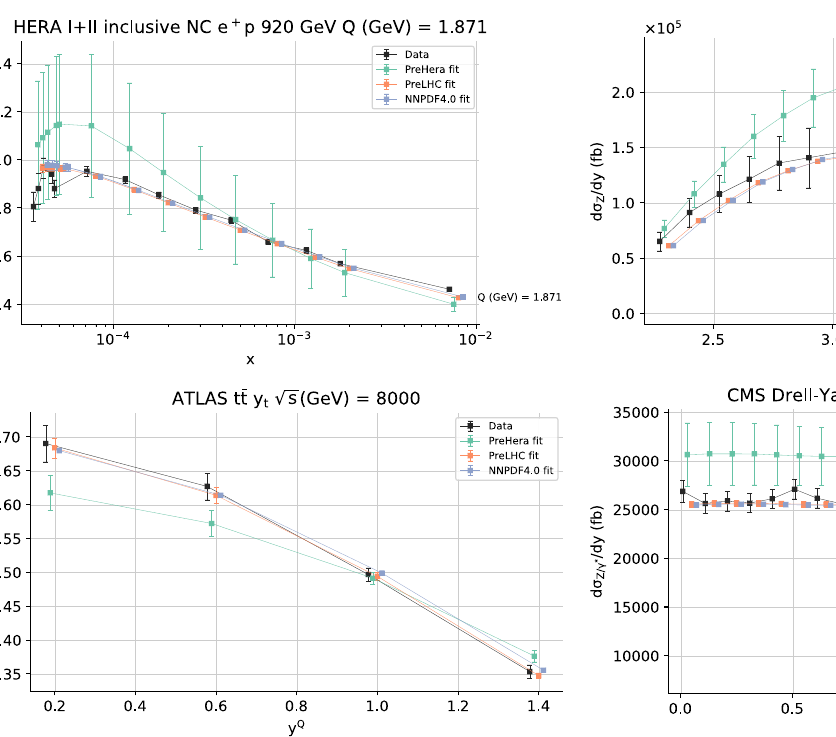
double-differential Drell–Yan (see text for details). Note that only the HERA structure function data enter the pre-LHC fit (but not the pre- LHC fit), and all the remaining data do not enter either the pre-HERA or pre-LHC fit. The uncertainty in the data corresponds to the total diagonal experimental